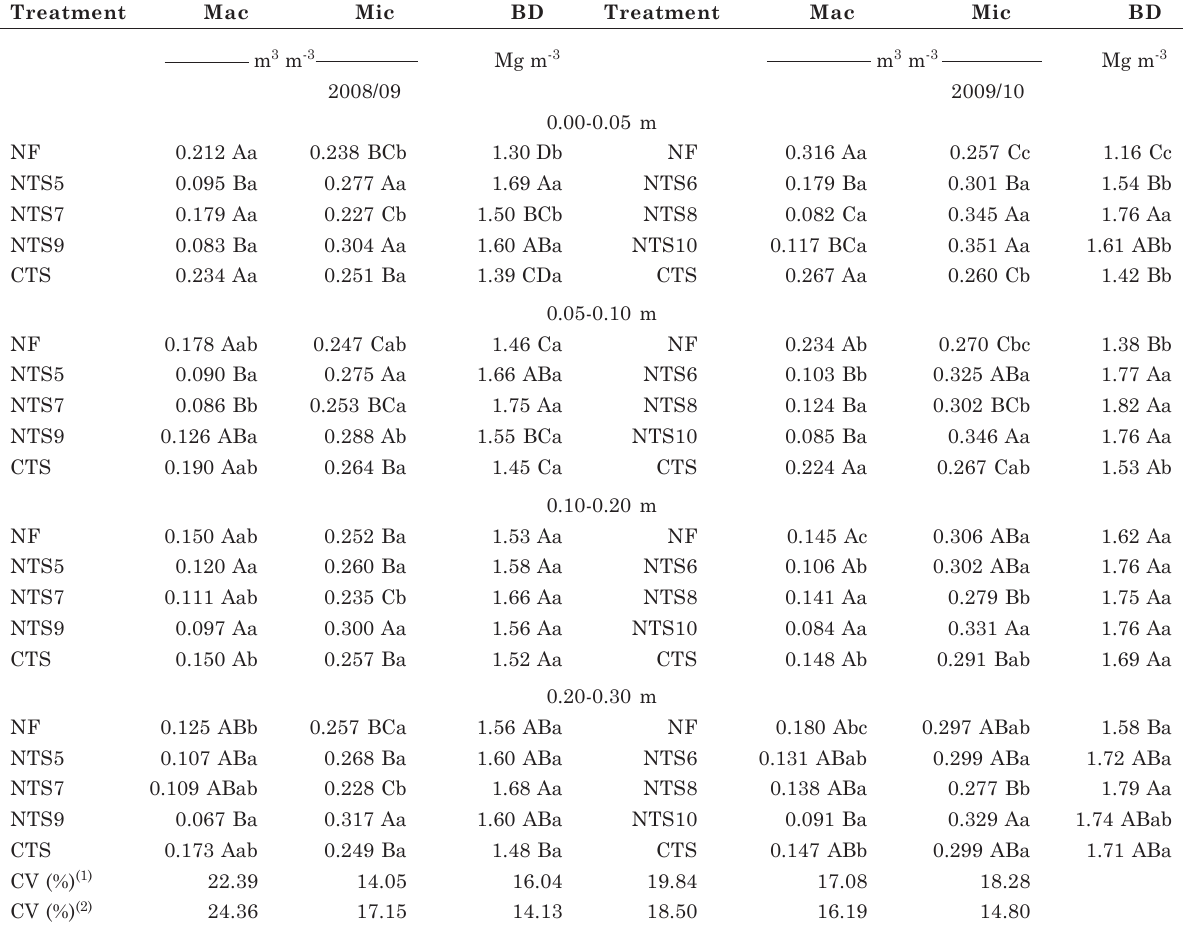
Table 3. Macroporosity (Mac), microporosity (Mic) and bulk density (BD) in four layers of a Red Oxisol after different management periods and under native